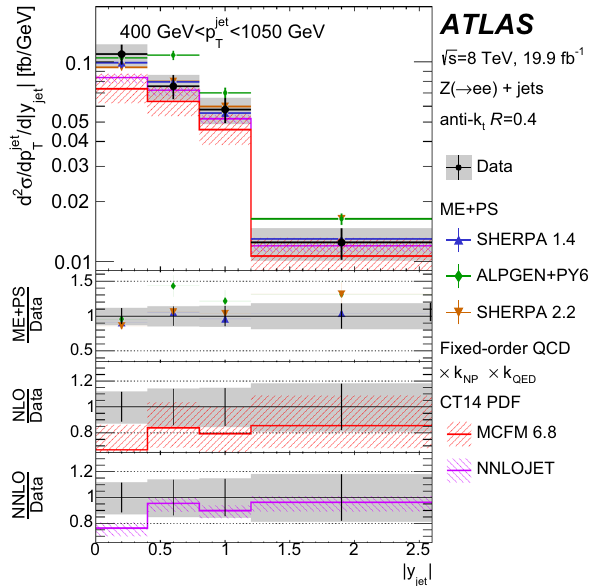
Fig. 11 The double-differential Z + jets production cross-section as a Fig. 12 The double-differential Z + jets production cross-section as a < 400GeV range. The data are < 1050GeVrange.Thedataare function of | y jet | in the 300GeV < p jet functionof | y jet | inthe400GeV < p jet T T compared with the Sherpa v. 1.4, Sherpa v. 2.2 and Alpgen+Pythia compared with the Sherpa v. 1.4, Sherpa v. 2.2 and Alpgen+Pythia partonshowerMCgeneratorpredictionsandwiththefixed-ordertheory partonshowerMCgeneratorpredictionsandwiththefixed-ordertheory predictions.Thefixed-ordertheorypredictionsarecorrectedforthenon- predictions.Thefixed-ordertheorypredictionsarecorrectedforthenon- perturbativeandQEDradiationeffects.Thefixed-order calculationsare perturbativeandQEDradiationeffects.Thefixed-ordercalculationsare performed using the CT14 PDF. The total statistical uncertainties are performed using the CT14 PDF. The total statistical uncertainties are shown with error bars. The total uncertainties in the measurement and shown with error bars. The total uncertainties in the measurement and in the fixed-order theory predictions are represented with shaded bands. in the fixed-order theory predictions are represented with shaded bands. The total uncertainty in the measurement is the sum in quadrature of The total uncertainty in the measurement is the sum in quadrature of the statistical and systematic uncertainties except for the luminosity the statistical and systematic uncertainties except for the luminosity uncertainty of 1.9%. The total uncertainty in the fixed-order theory uncertainty of 1.9%. The total uncertainty in the fixed-order theory predictions is the sum in quadrature of the effects of the PDF, scale, and predictions is the sum in quadrature of the effects of the PDF, scale, and α α S uncertainties, and the uncertainties from the non-perturbative and S uncertainties, and the uncertainties from the non-perturbative and QED radiation corrections. Lower panels show the ratios of predictions QED radiation corrections. Lower panels show the ratios of predictions to data to